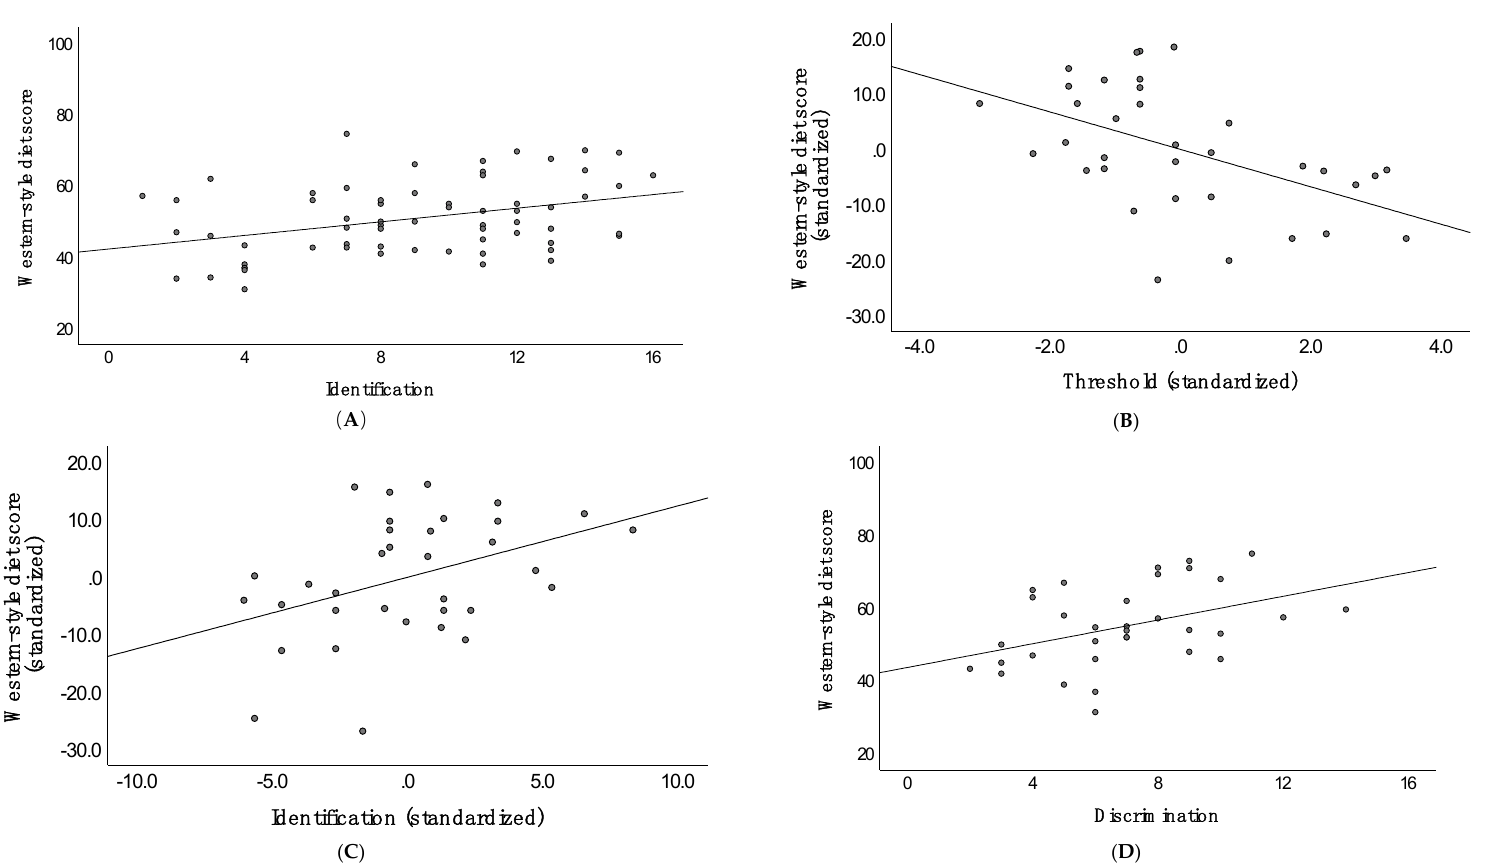
Figure 1. From top left (clockwise)—scatter plot between identification and Western-style diet (WSD) in people with idiopathic olfactory impairment; partial plots of the relationship between threshold, and identification, with WSD in people with sino-nasal disease olfactory impairment; and scatter plot of the relationship between discrimination and WSD in people with olfactory impairment due to trauma (please see Table 4 for associated r values). ( A ) Identification, ( B ) Threshold (Standarized), ( C ) Identification (Standarized) ( D ) Discrimination.